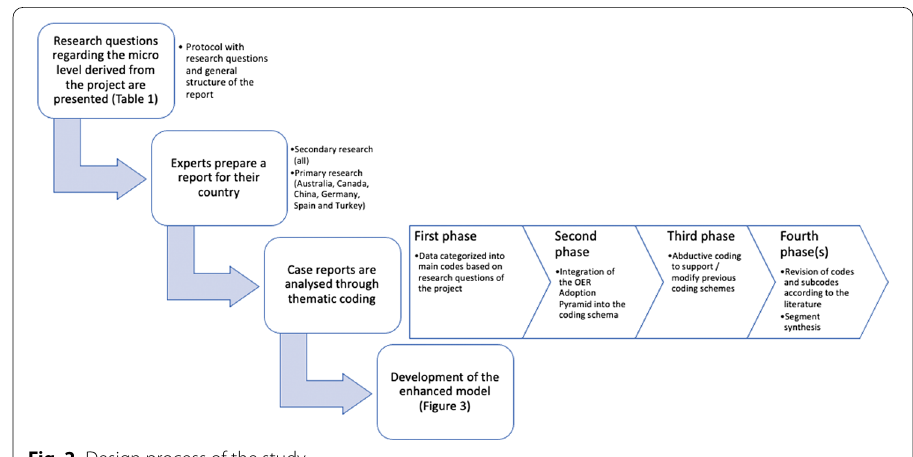
Fig. 2 Design process of the